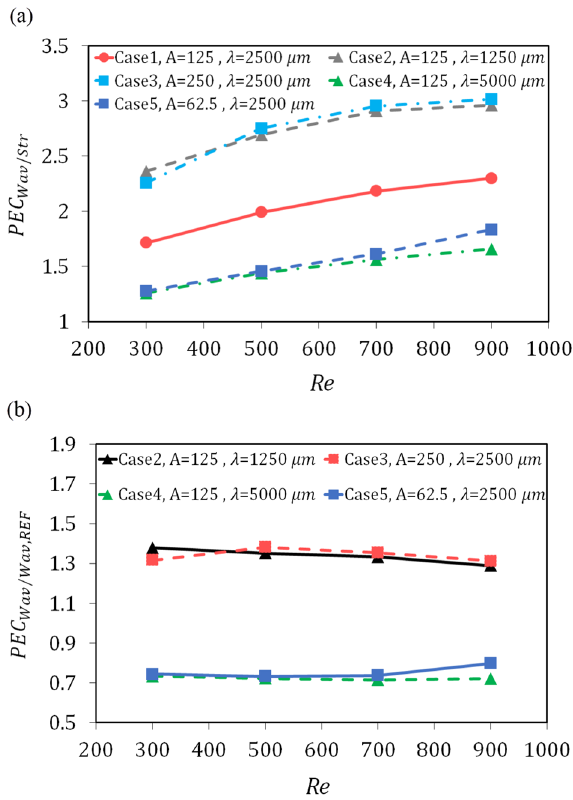
Figure 15. Performance evaluation criterion versus Reynolds number: ( a ) When straight pattern considered as the reference, and ( b ) when wavy case 1 considered as the reference geometry.